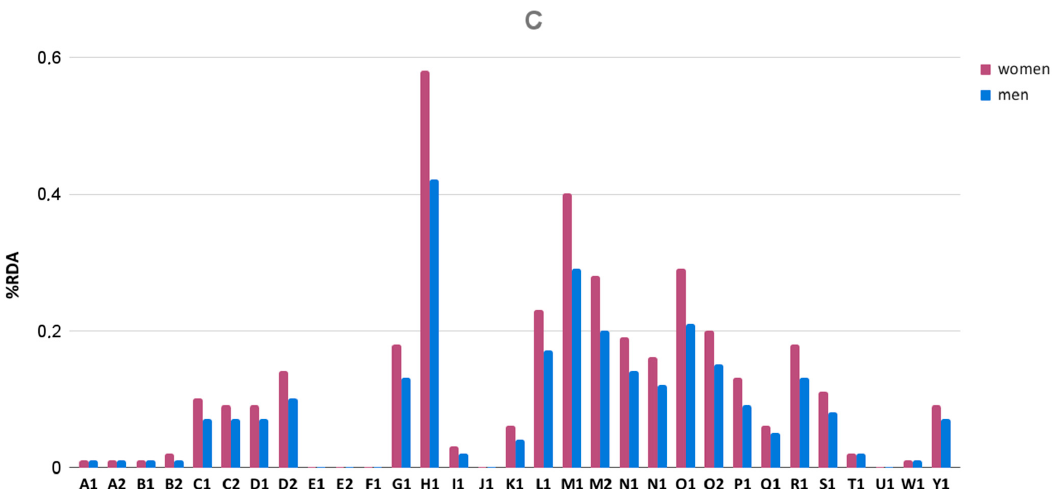
Figure 3. ( A ) Realization of RDA for iron by daily consumption of the analyzed unenriched dietary supplements. ( B ) Realization of RDA for iron by daily consumption of the analyzed enriched dietary supplements. ( C ) Realization of RDA for zinc by daily consumption of the analyzed dietary supplements.